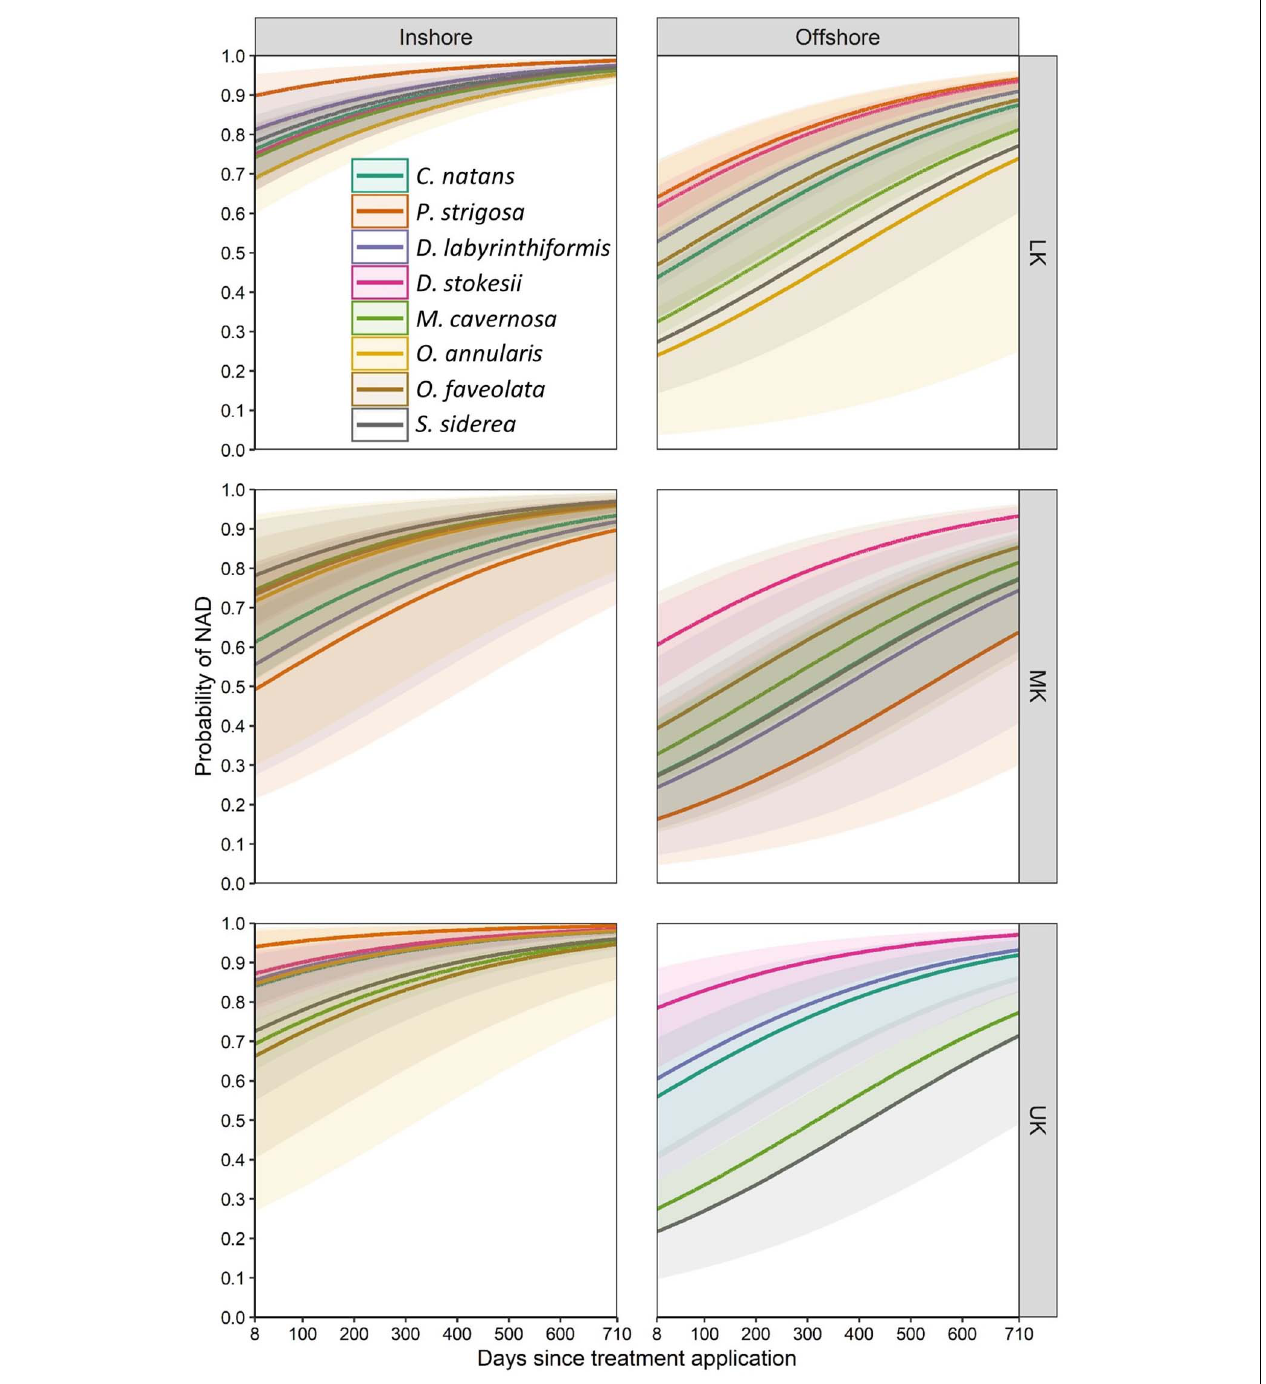
FIGURE 6 | Mean predicted probability (solid lines) of corals exhibiting no active disease (NAD) for eight species across two geographic variables: inshore/offshore and upper/middle/lower Keys (UK/MK/LK). Shaded areas represent 95% confidence intervals. Model predictions represent corals initially treated with amoxicillin and retreated as necessary during subsequent monitoring